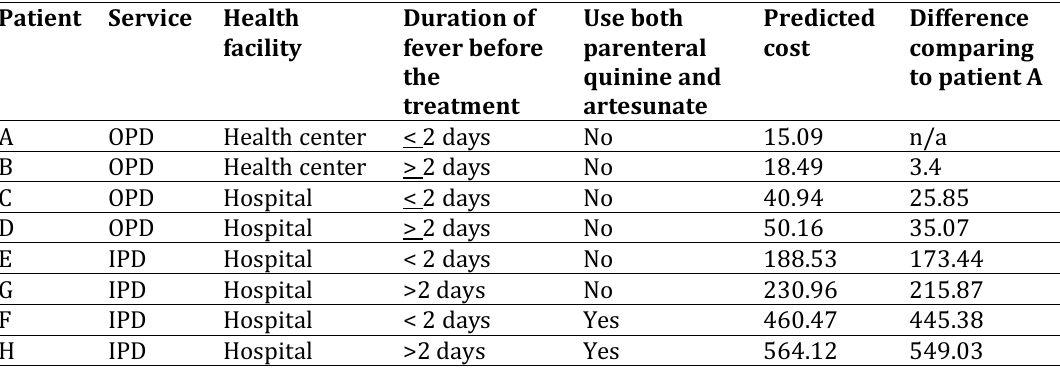
Table 6: Predicted direct medical